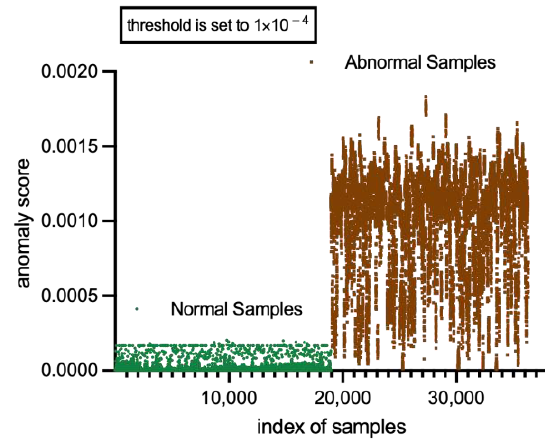
Figure 17. Anomaly scores of normal samples and abnormal (performance failures) samples pro- duced by CL-MMAD using MSE loss.